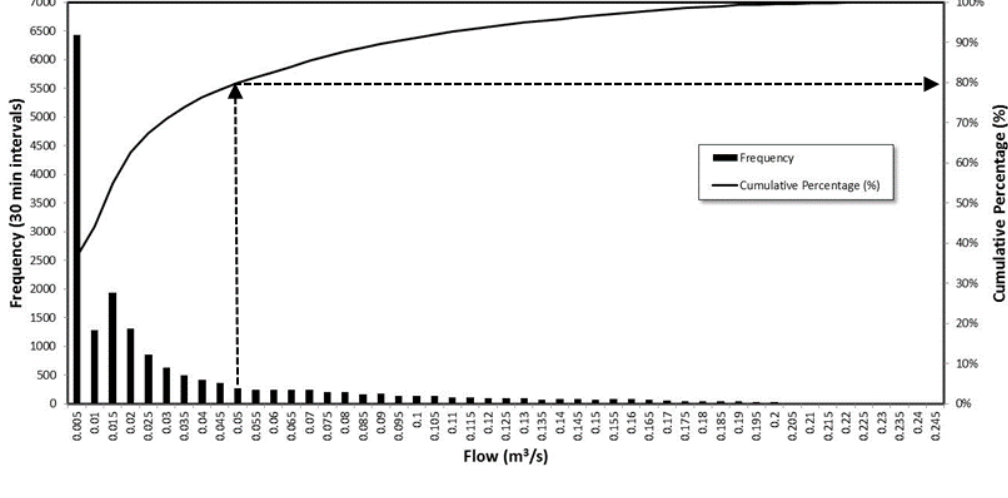
(H201) over time ( b ).